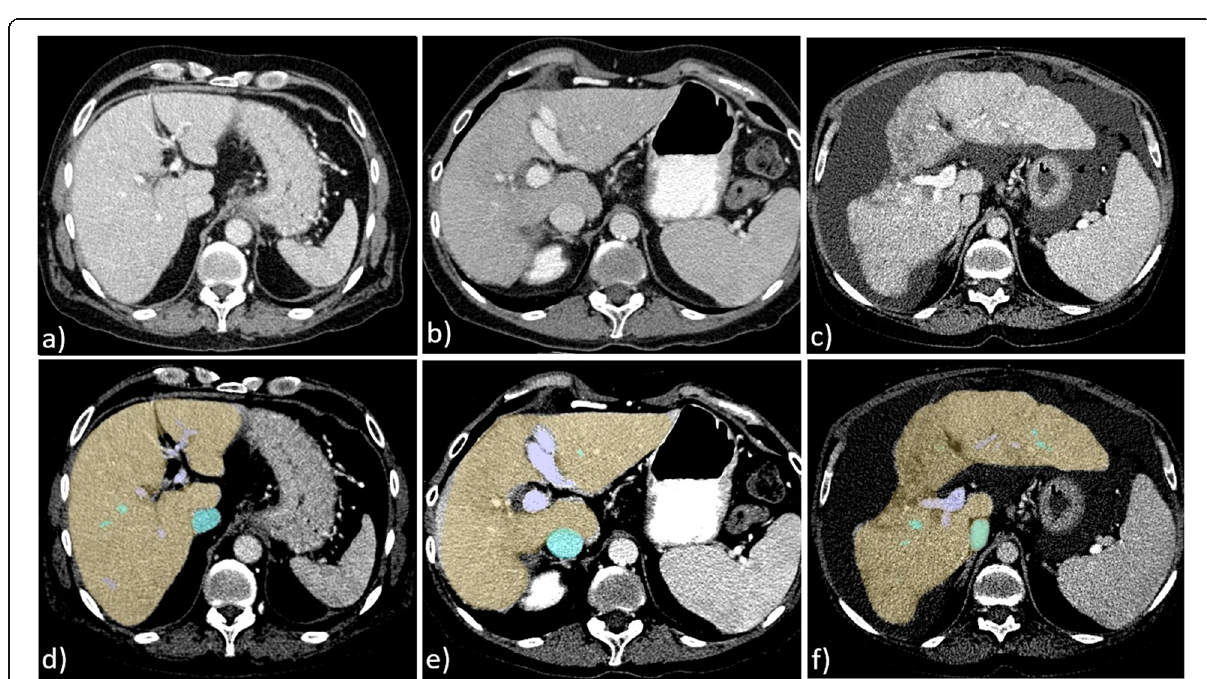
Fig. 1 Multiphase computed tomography of three patients. a – c Transversal reconstruction of three patients in portal-venous phase. d – f Pre-processing with semiautomatic liver and vein delineation. a , d Patient with Child-Pugh class A: no changes in liver size or liver parenchyma were observed; all models rated the liver as Child-Pugh class A. b , e Patient with Child-Pugh class B: slight changes in liver configuration as well as heterogeneity of liver parenchyma were observed; only the convolutional network and the expert radiologists ’ prediction rated the liver correctly as Child-Pugh class B, whereas the linear regression and the random forest rated it as a Child-Pugh class C. c , f Patient with Child-Pugh class C: overall appearance of the liver exhibits characteristic changes (liver configuration, size, and parenchyma texture); all models rated the liver as Child-Pugh class